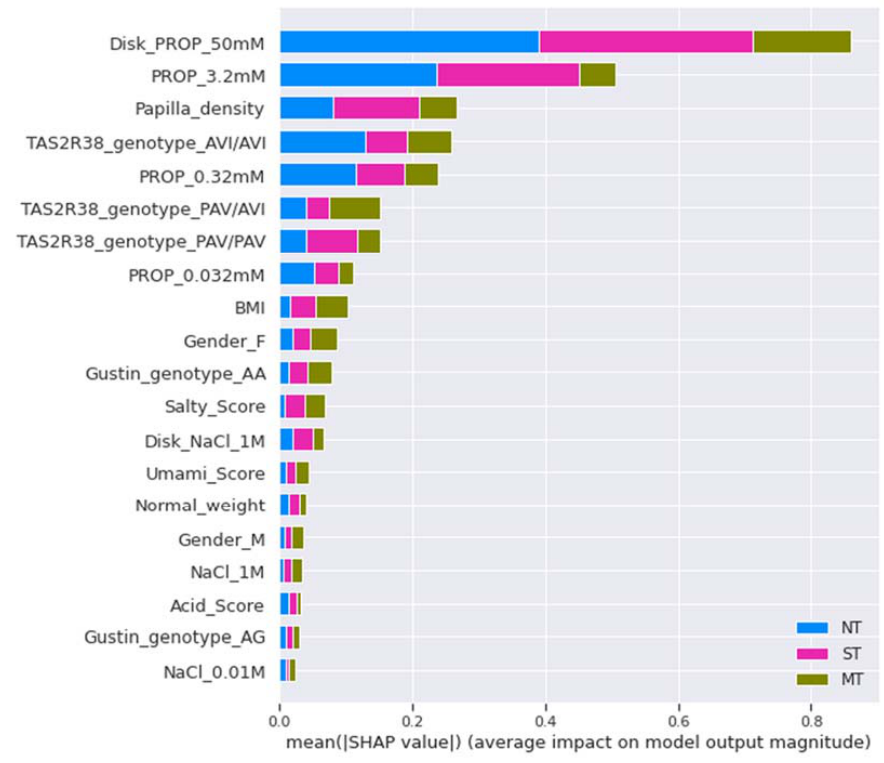
Figure 5. Feature importance of the CatBoost classifier in the training set. The X ‐ axis represents the average impact on the model output, while the Y ‐ axis represents the order of importance of the features in the training set to understanding the categories of each PROP taster status.